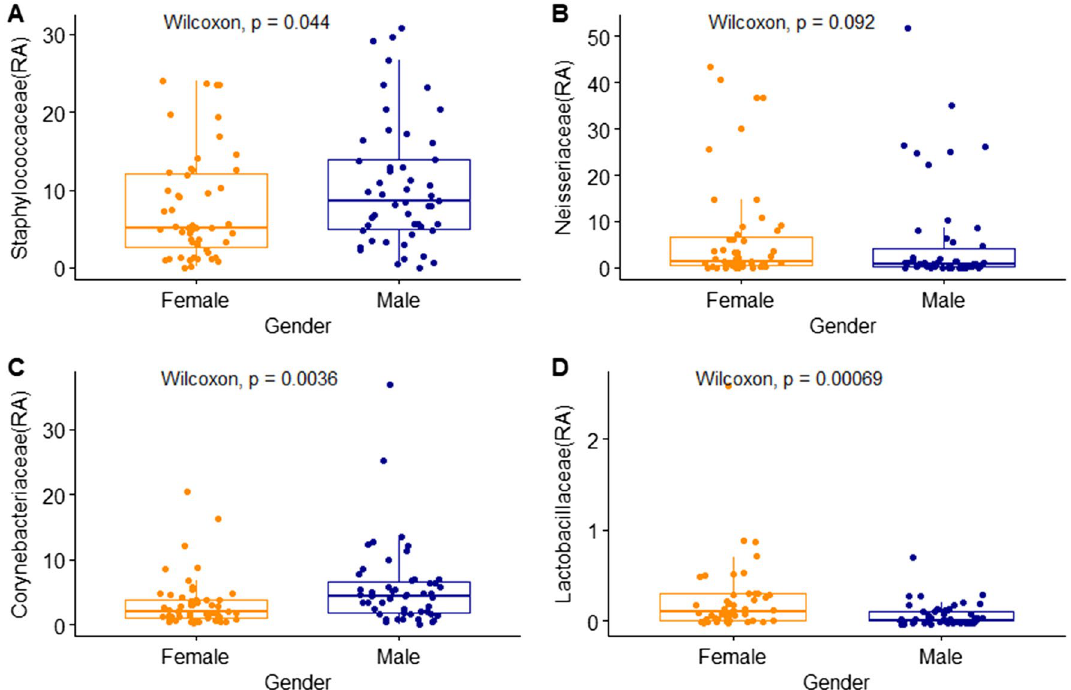
Figure 5. Relative abundance (%) of four families in skin samples between female and male. ( A ) Staphylococcaceae; ( B ) Neisseriaceae; ( C ) Corynebacteriaceae; ( D ) Lactobacillaceae. Wilcoxon signed-rank test was used for statistical analysis. P values are displayed in the figures.